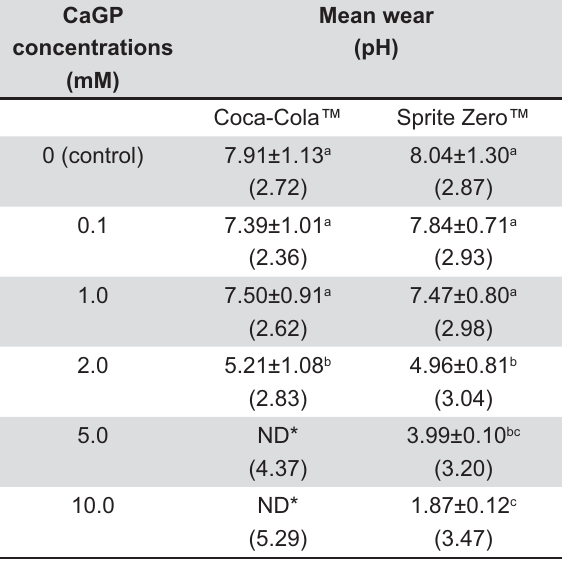
Table 1- Mean wear (±SD, μm) of bovine enamel